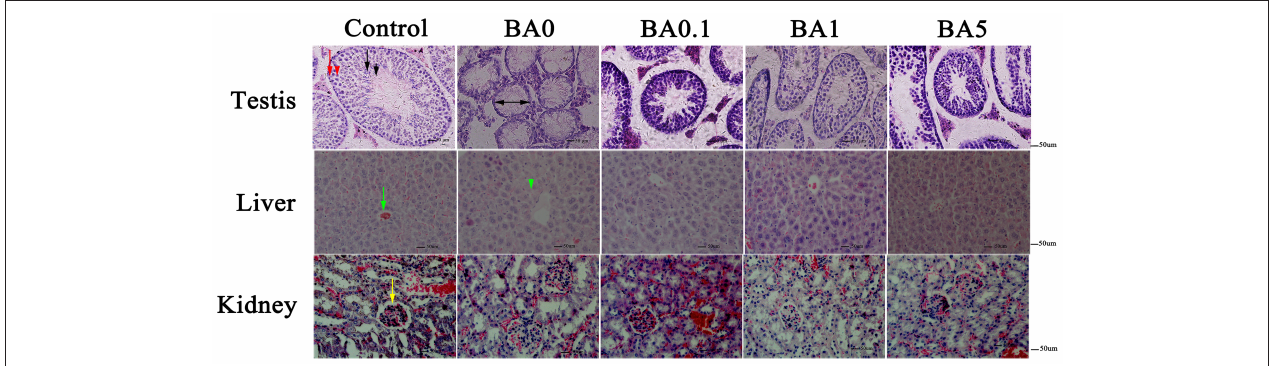
FIGURE 3 | Effect of RAAE on busulfan-induced histological damage in different organs. In the first panel, the testis in the control group showed normal seminiferous tubules. Red arrow indicates spermatogonia, red arrowhead indicates primary/secondary spermatocytes, black arrow represents spermatids, and black arrowhead represents spermatozoa. The diameter of the seminiferous tubules is shown by black two-headed arrows. In the second panel, the central vein is indicated with a green arrow, and cell necrosis is shown by a green arrowhead. In the third panel, glomerulus with abundant capsular space is indicated by a yellow arrow.